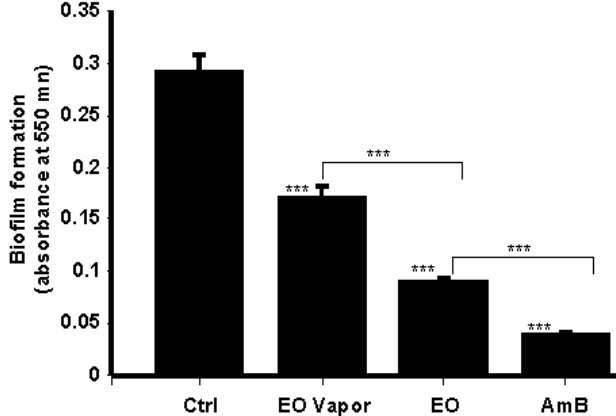
Figure 4. Mentha × piperita essential oil inhibited C. albicans biofilm formation . C. albicans (10 5 )